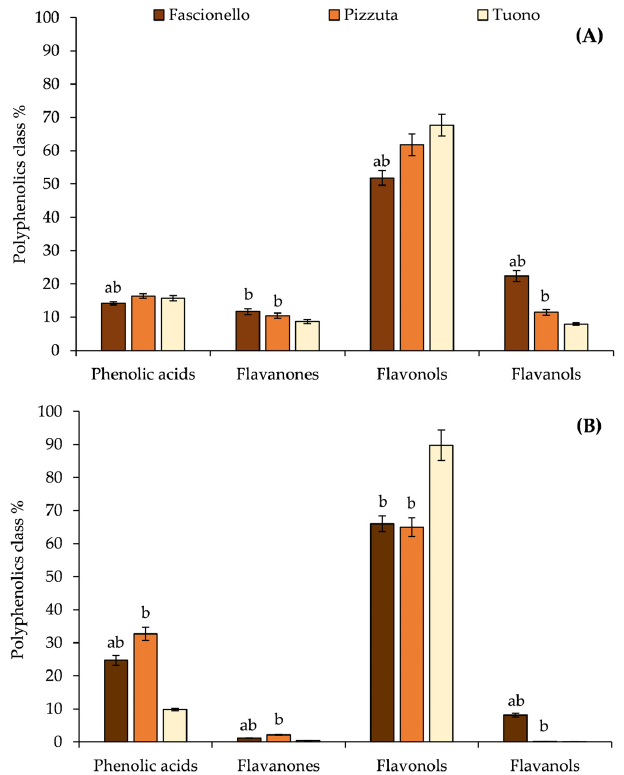
Figure 5. Percentage distribution (%) of the various classes of polyphenols identified in the three different cultivars investigated (Fascionello, Pizzuta, and Tuono) in blanched skin extracts (BSE, panel ( A )) and blanch water extracts (BWE, panel ( B )). a p < 0.05 vs. Pizzuta cultivar; b p < 0.05 vs. Tuono cultivar. Table 5. Antioxidant and free-radical scavenging activity determined by spectrophotometric and spectrofluorimetric tests based on different environments and reaction mechanisms. Results, which represent the average ± standard deviation of three independent experiments in triplicate ( n = 3), were expressed as g of trolox equivalents (TE)/100 g of dried extract (DE). Numbers from I to VI represent different